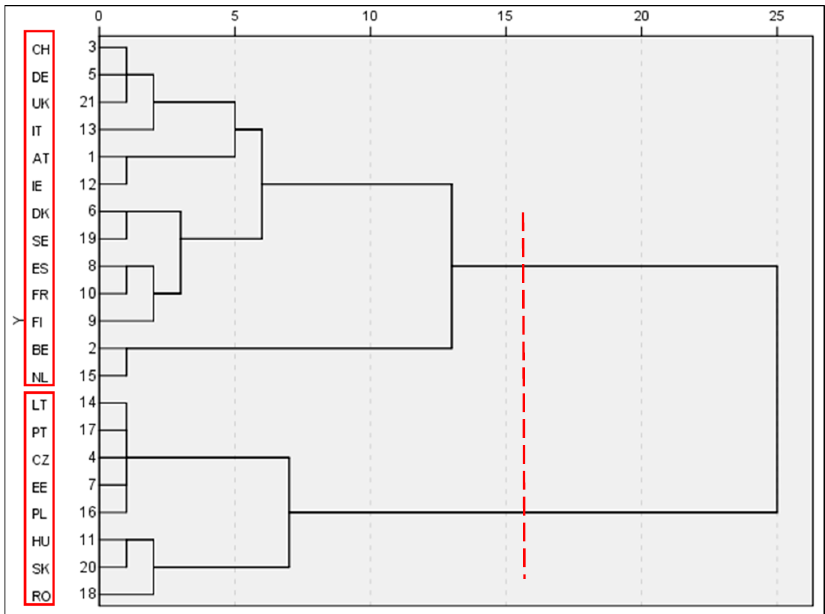
Figure 2. The classification tree based on the hierarchical clustering analysis for